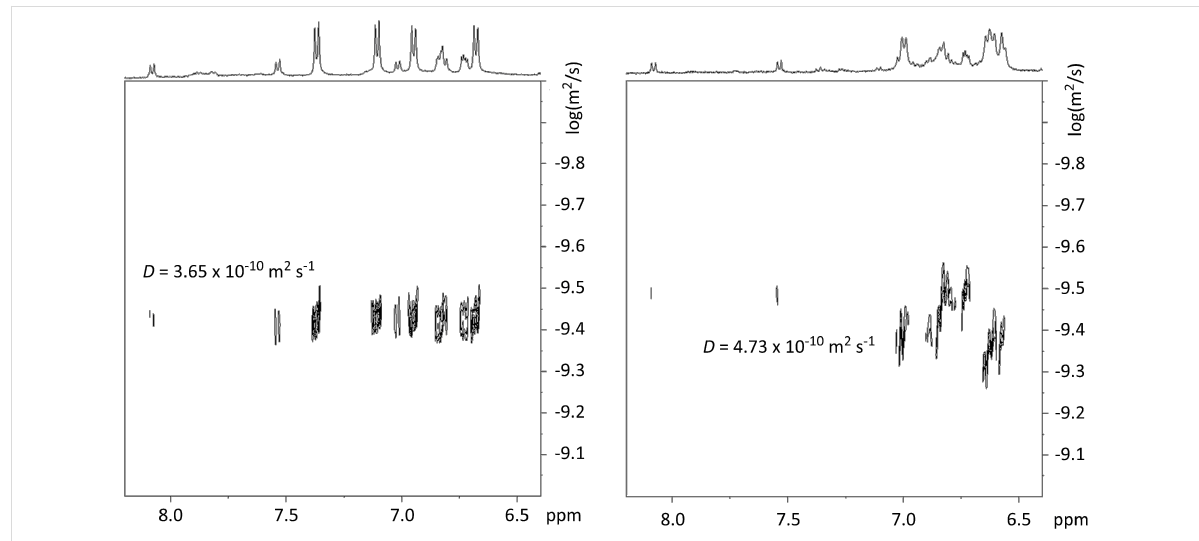
Figure 8: DOSY NMR spectra (500 MHz in MeOD at 25 °C) of the foldable container 10 after synthesis (left) and after irradiation with light of the wavelength λ = 365 nm (right).